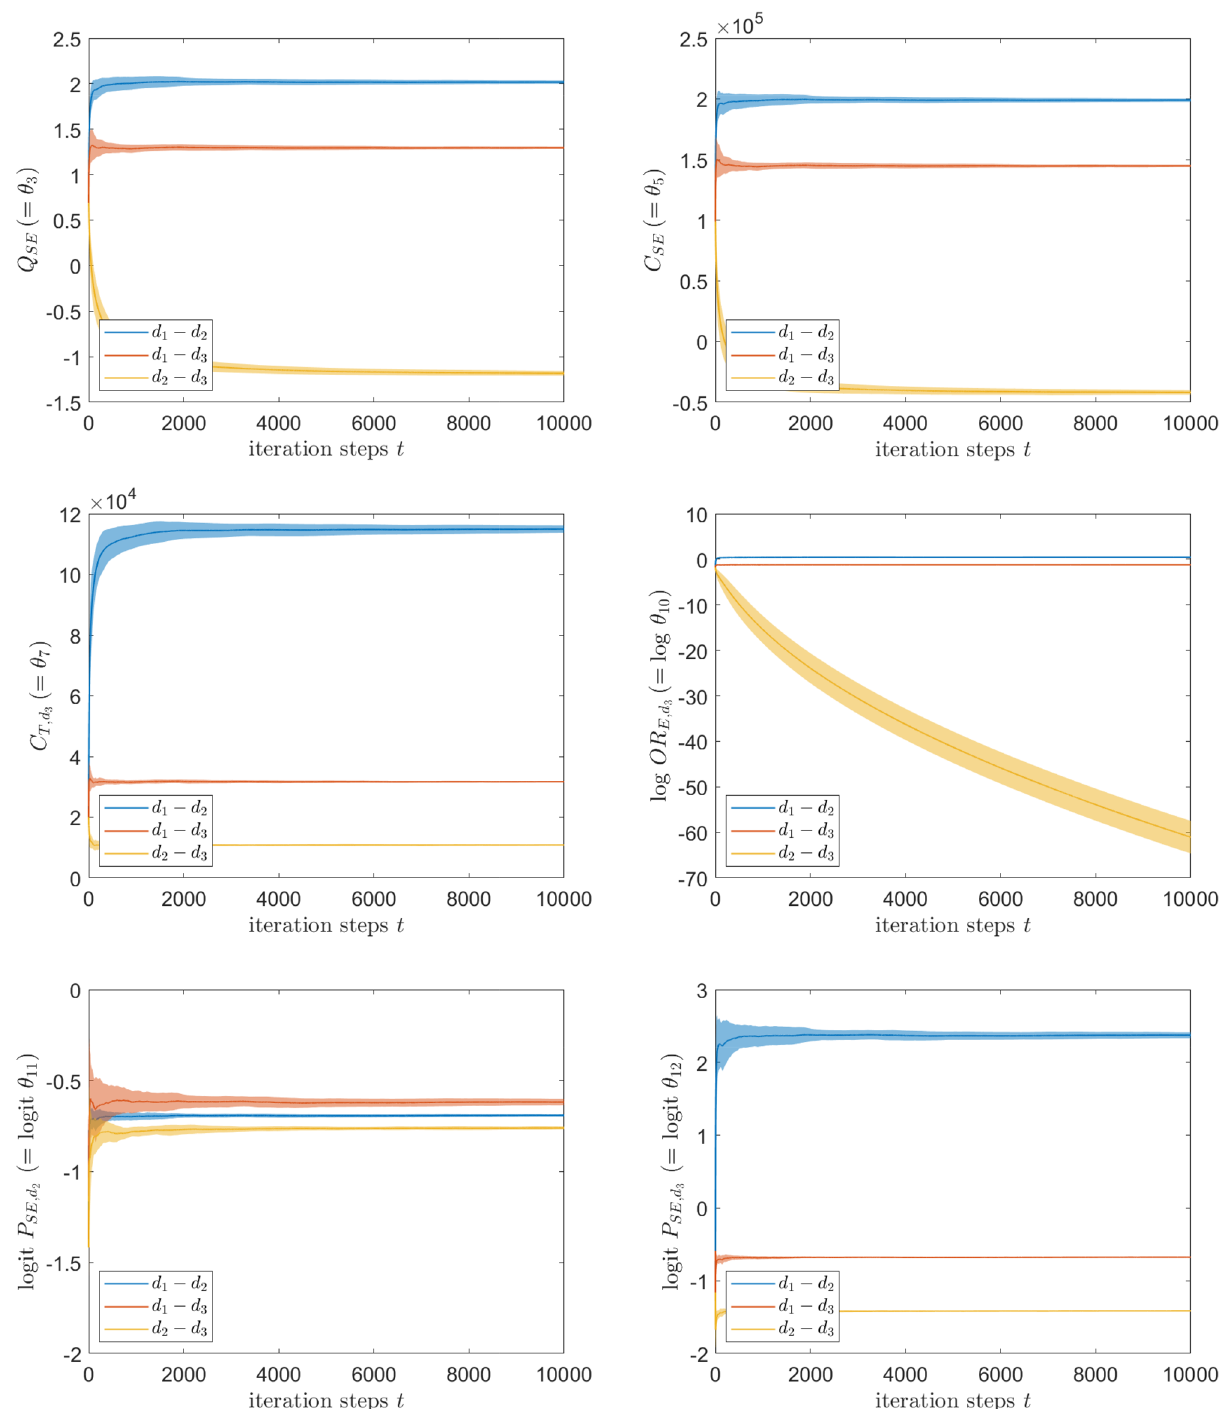
Figure 3. The pairwise probabilistic thresholds for the synthetic testcase found by the stochastic approximation with Polyak-Ruppert averaging as functions of iteration steps t . The results for θ 3 (left top), θ 5 (right top), θ 7 (left middle), log θ 10 (right middle), logit (θ 11 ) (left bottom) and logit (θ 12 ) (right bottom) are shown respectively. For each pair of two treatments, the line and the shaded area represent the mean and its standard error estimated from 20 independent runs,